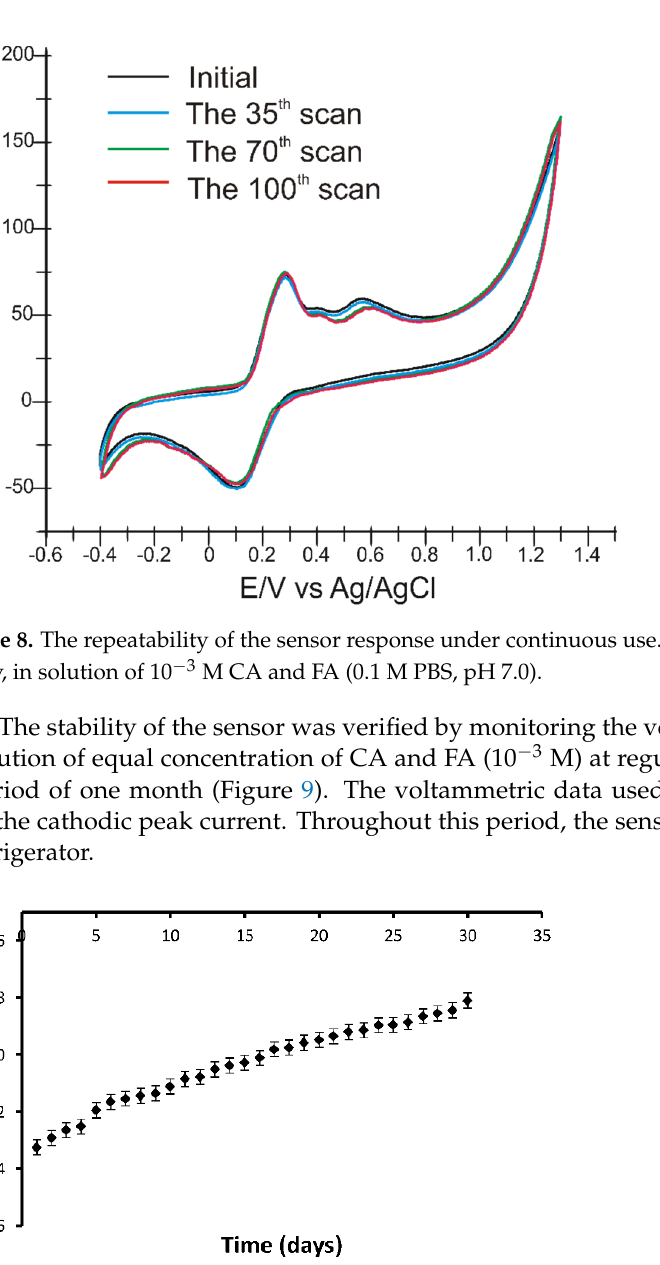
Figure 9. The long-term stability of the sensor response. Conditions: cyclic voltammetry measure- ments, 10 − 3 M CA and FA (in 0.1 M PBS, pH 7). The error bars indicate the standard error for three measurements with the same electrode.